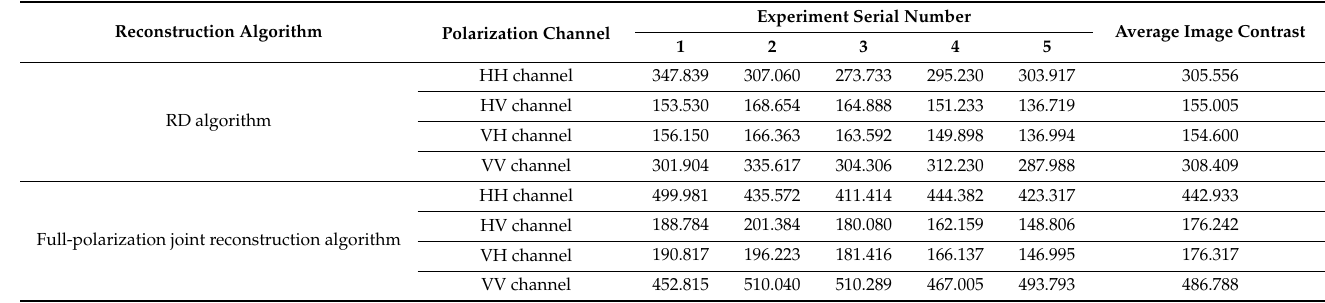
Table 3. ISAR-reconstructed image contrast.